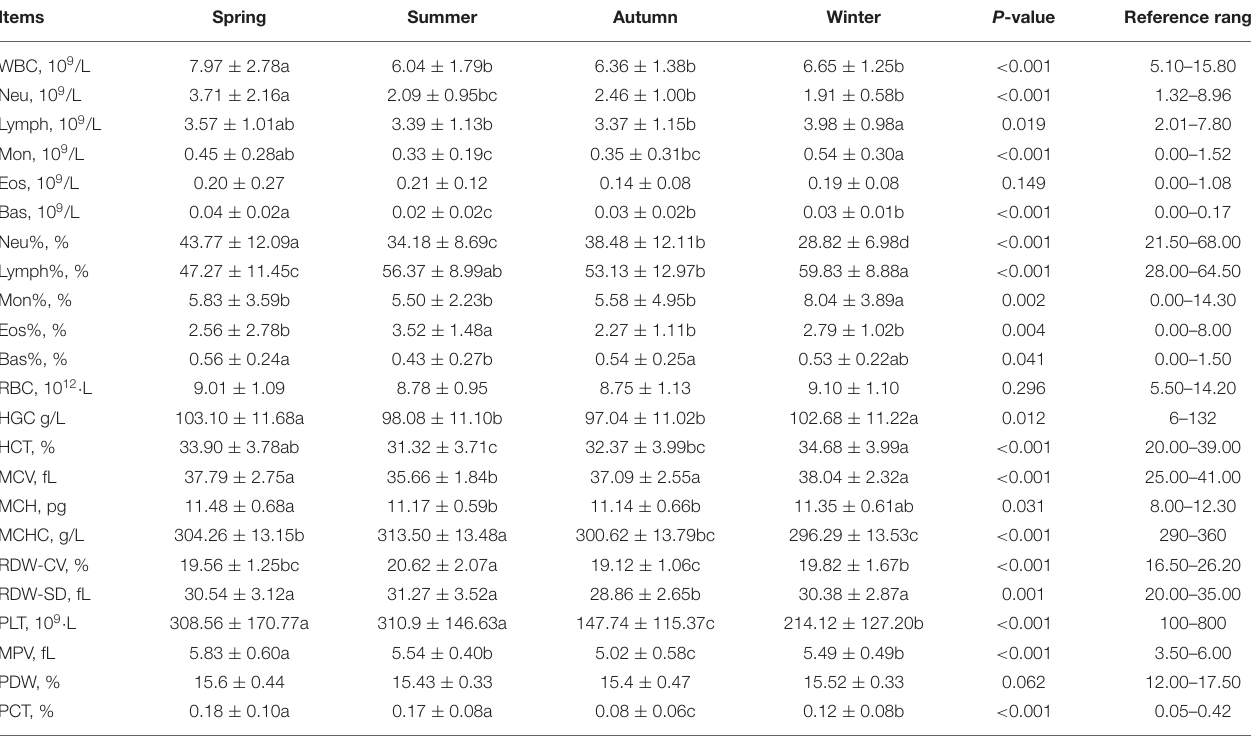
TABLE 3 | Effects of seasonal changes on serum physiological parameters.